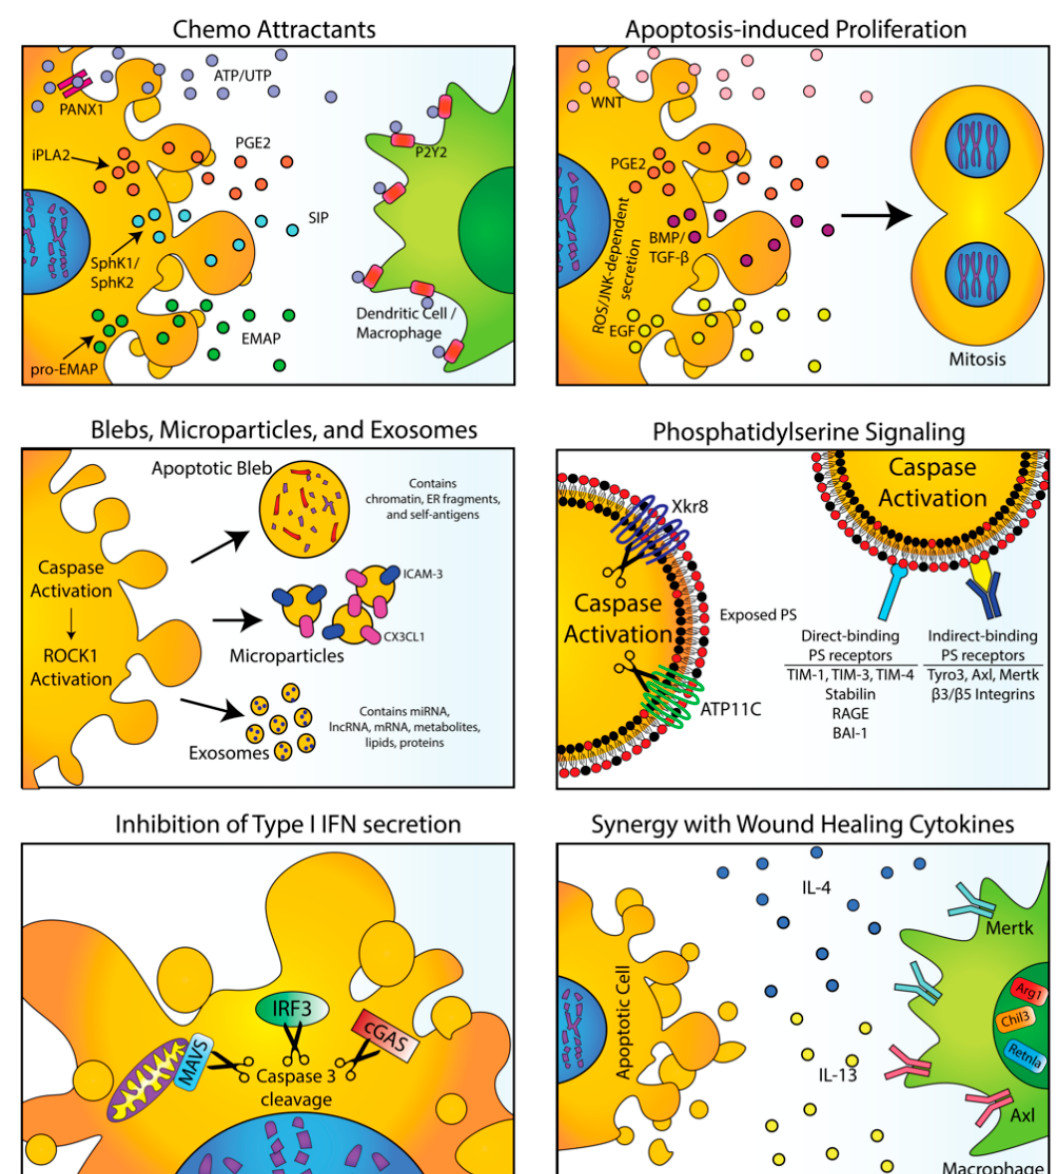
Figure 1. Caspase-dependent interactions between apoptotic and viable cells. Top left: Chemo attractants. Signaling molecules (including ATP/UTP, PGE2, S1P, and EMAP are released by apoptotic cells and attract immune cells (including dendritic cells and macrophages). Top right: Apoptosis-induced proliferation. Released signaling molecules (WNT, PGE2, BMP/TGF- β , and EGF) promote the proliferation of nearby cells. Bottom left: Blebs, microparticles, and exosomes. Apoptotic cells release vesicles of various sizes containing various signaling molecules taken from the dying cell. Bottom right: Phosphatidylserine (PS) signaling. PS is exposed on the outer surface of apoptotic cells by the activation of scramblases (i.e., Xkr8) and the inactivation of flippases (i.e., ATP11C). PS exposure interacts with direct-binding PS receptors (that may act as tethering receptors) and indirect-binding PS receptors, which require PS-sensing ligands and are known to promote immunosuppressive signaling and efferocytosis.